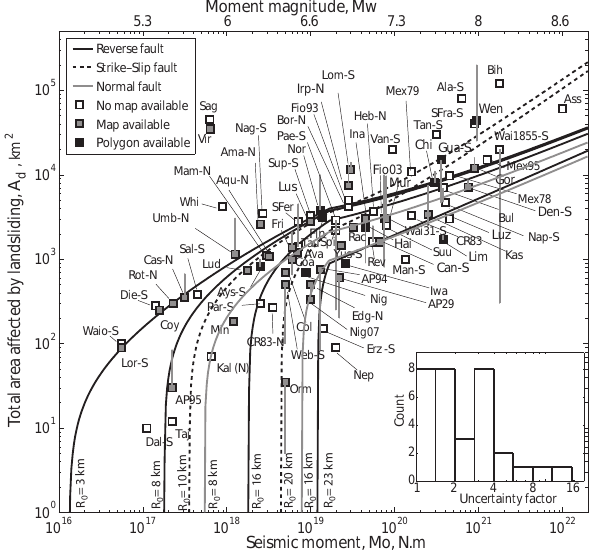
Figure 1. Total area affected by landsliding against seismic moment and moment magnitude for 83 earthquakes. Vertical error bars rep- resent different estimate of A d for the 27 cases where they could be obtained. Name codes (defined in Table 1) are shown for each earth- quake, followed by S or N for strike-slip and normal faults, while all other cases are reverse fault earthquakes. R 0 is the mean depth of wave emission. The prediction of the seismologically consistent model is shown for reverse, normal, and strike-slip faults at differ- ent depth with solid black, solid grey, and dashed lines, respectively. Inset: distribution of the uncertainty factor (upper estimate/best es- timate or best estimate/lower